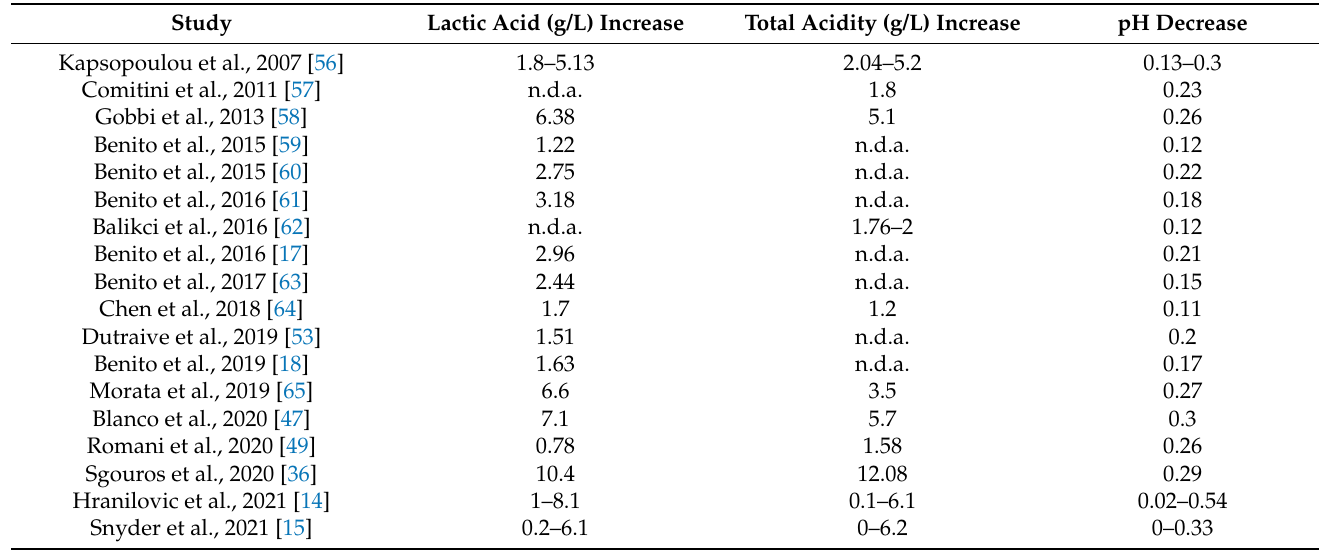
Table 3. Summary of sequential combinations between L. thermotolerans and Saccharomyces and their influence on the final lactic acid concentration, pH, and total acidity of the wine. The table reports the increases in lactic acid and total acidity and the reductions in pH that took place during alcoholic fermentation compared to the initial value of the grape juice before alcoholic